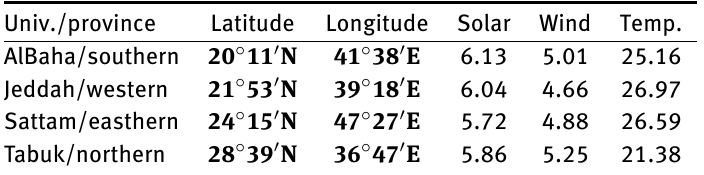
Table 1: Meteorological data of the selected universities.